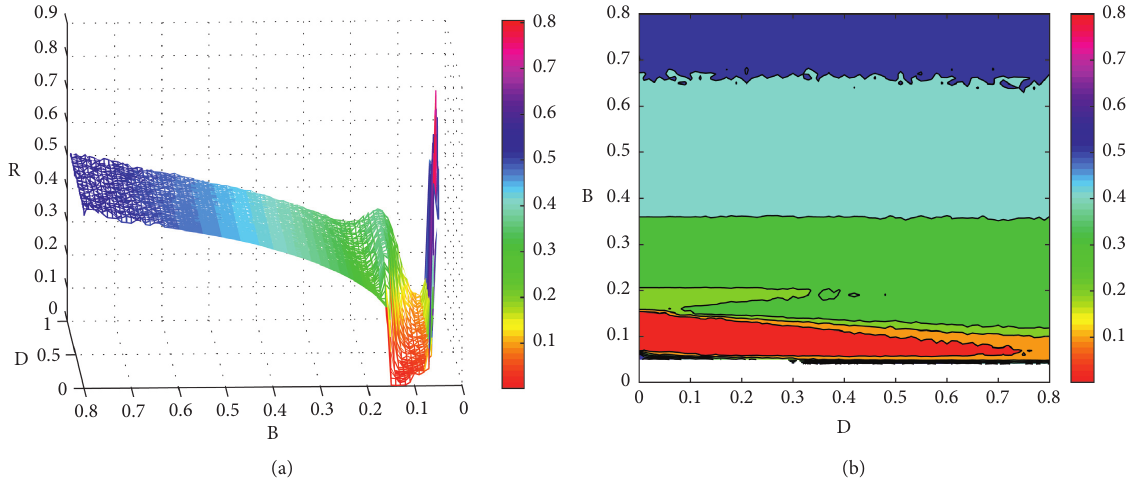
Figure 7: When flux-controlled memristor parameters are determined, the plot of coherent resonance coefficient R of FHN neuron system varying with phase noise amplitude B and noise intensity D . (a) 3D view; (b) The floor